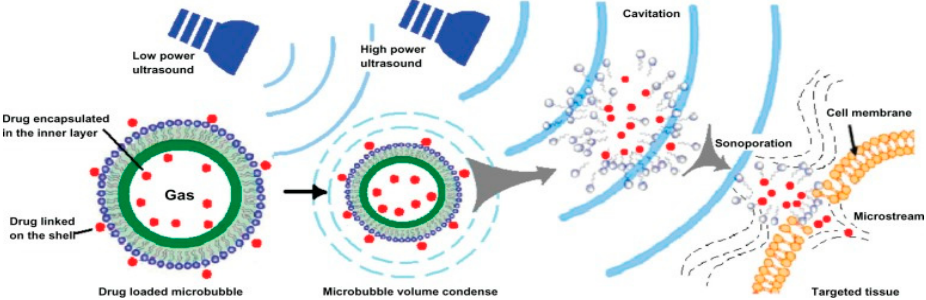
Figure 2. Schematic illustrating low and high power ultrasound assisting in drug delivery though microbubbles and cavitation (Source: Zhao et al. [36]. Licenced under a Creative Commons Attribution License).